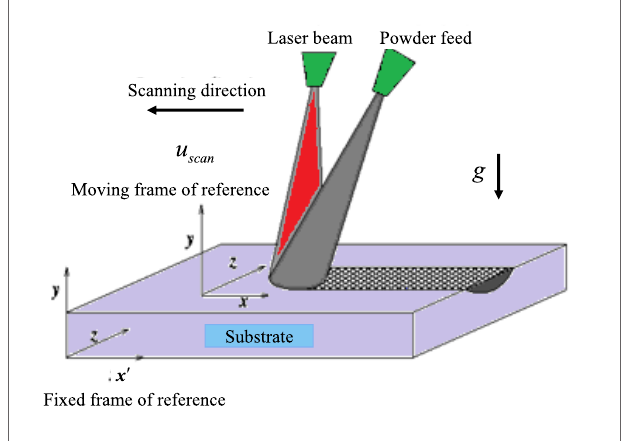
FIGURE 1 | Schematic diagram of a typical laser surface alloying process